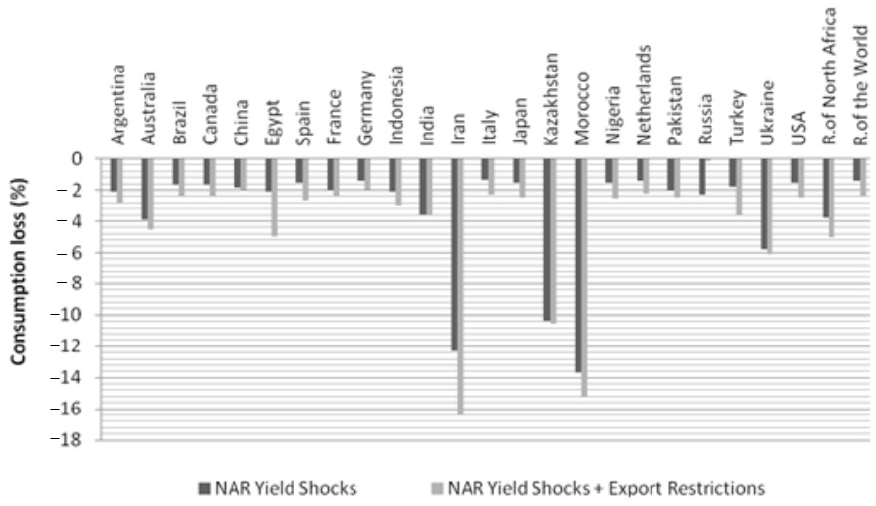
Figure 4. Wheat consumption at risk due to productivity shocks + export restrictions. Table 5. NAR values, productivity & export restriction-induced shocks (Scenario YQ) *. Protein Energy Iron Zinc Folate